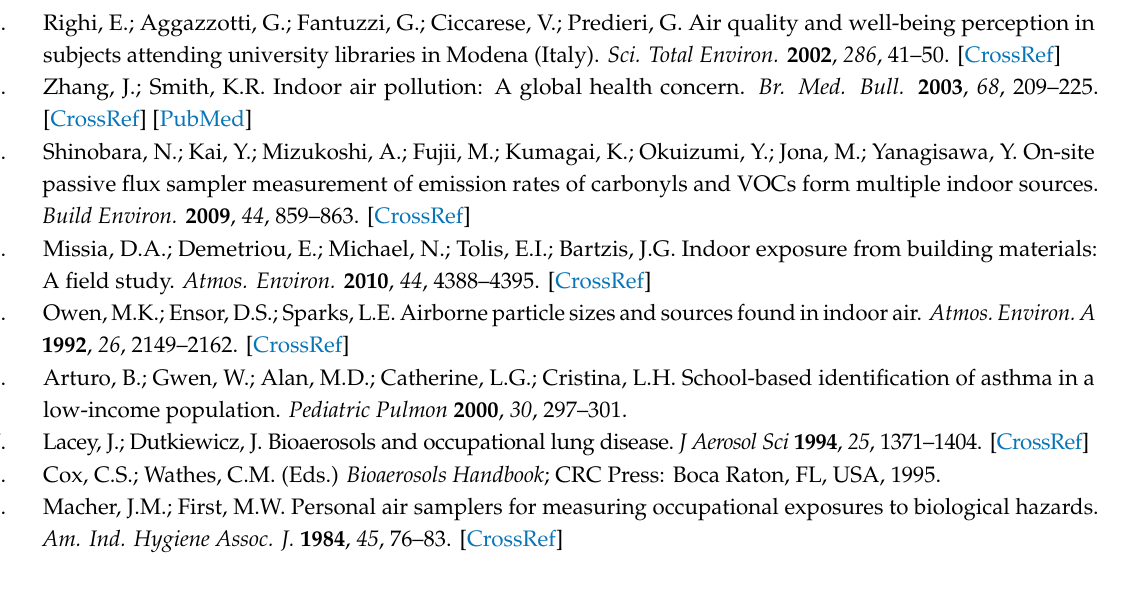
Figure S1: Relationship between airborne bacterial concentration and environmental factors in daycares, Figure S2: Relationship between airborne bacterial concentration and environmental factors in medical facilities, Figure S3: Relationship between airborne bacterial concentration and environmental factors in elder care facilities, Figure S4: Relationship between airborne bacterial concentration and environmental factors in postnatal care